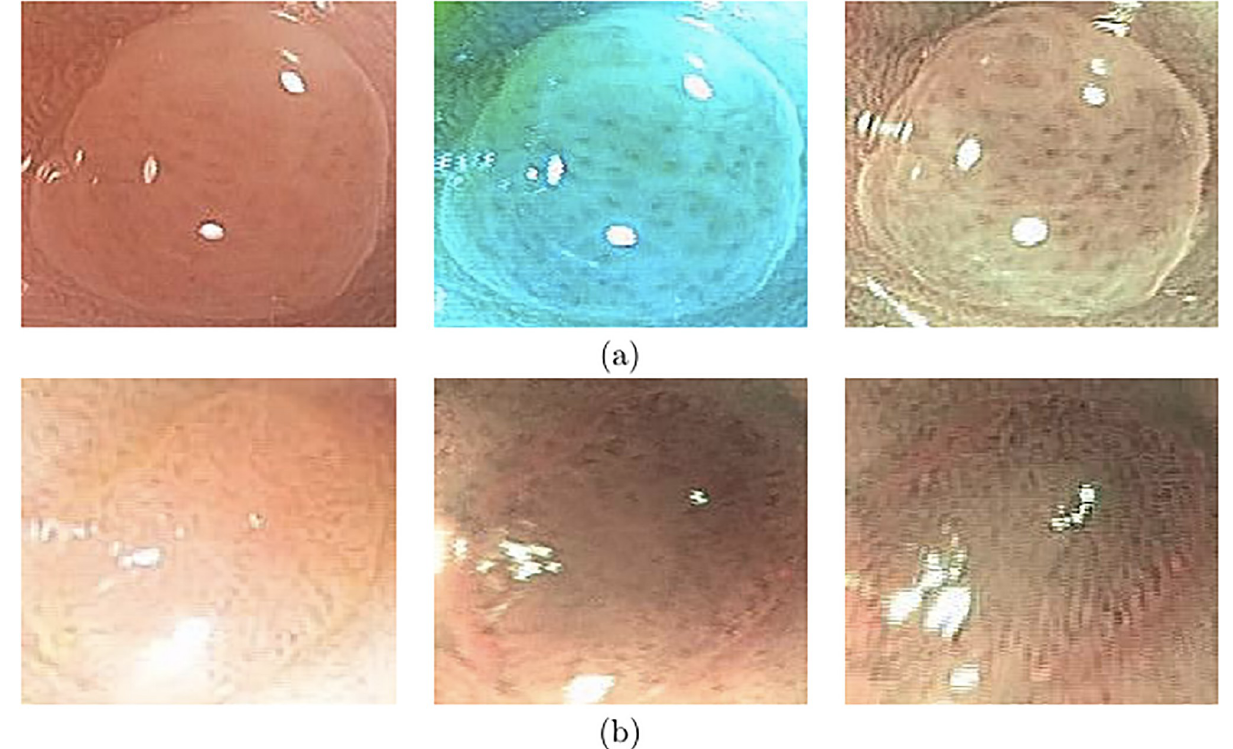
Fig 8. Missclassified sequences: Sample frames from different sequences that could not be correctly classified by almost all models. (a) and (b) are sequences 5 and 6, respectively, where 5 is of type adenomatous and 6 is of type hyperplastic.